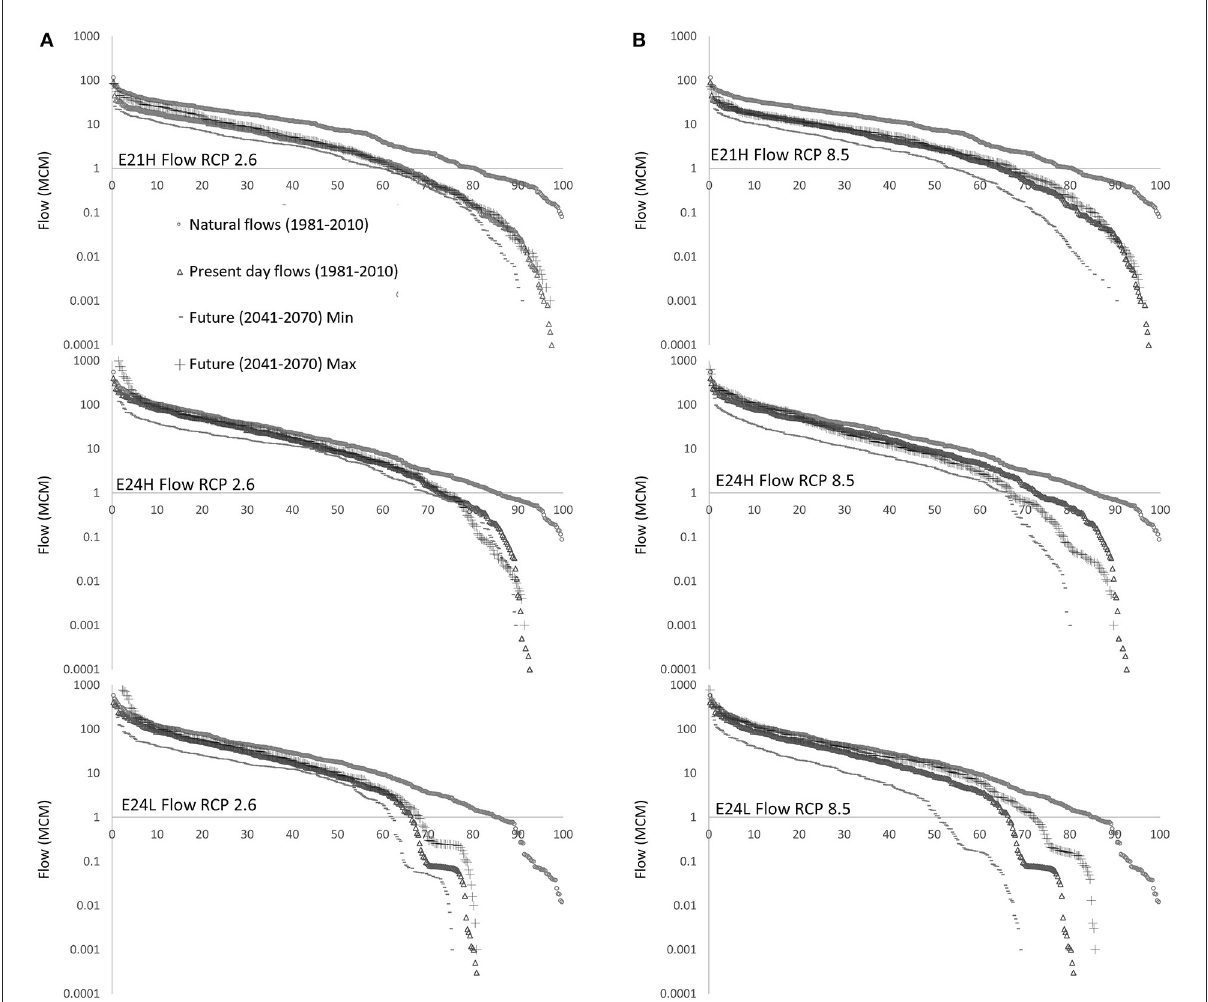
FIGURE4 Uncertainty (minimum and maximum scenarios) in future flow (MCM; shown on a log scale) relative to natural and present day simulated data for EWR site 6 (E21H quaternary; row 1), site 4 (E24H quaternary; row 2 figures) and 5 (E24L quaternary; row 3 figures) under RCPs (A) 2.6 and (B) 8.5.